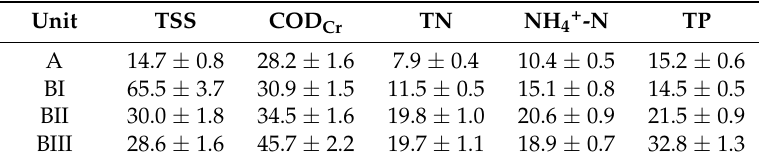
Table 5. Average relative pollutant removal rate R r (%) of treatment cells.